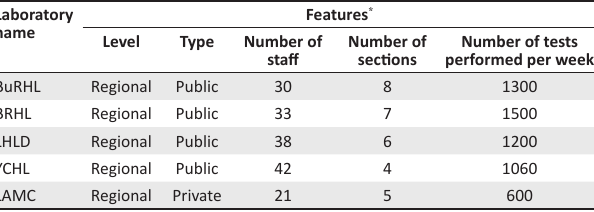
TABLE 1: Laboratories included in Cameroon’s first cohort of the Strengthening Laboratory Management Toward Accreditation